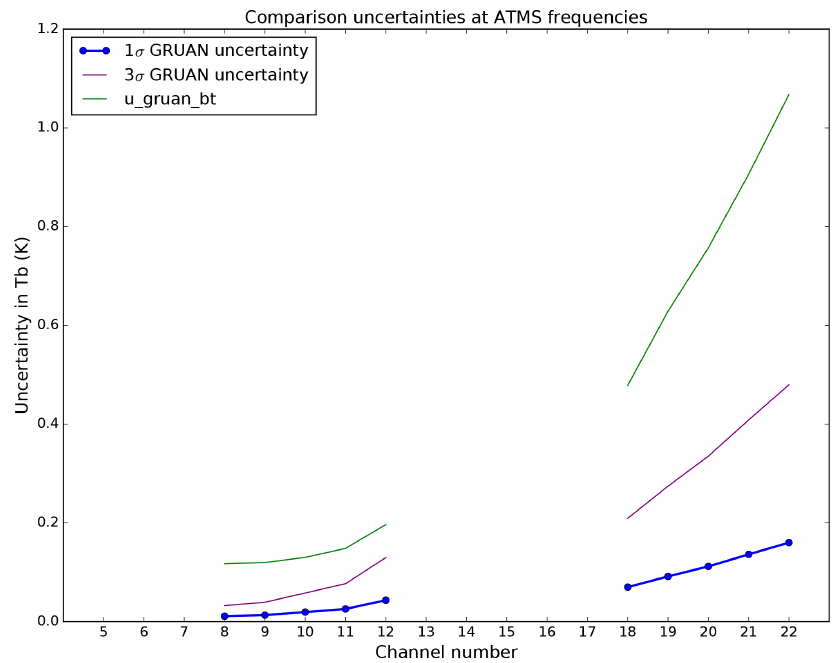
Figure 9. The 1 σ standard deviation of the uncertainty distribution from the GRUAN contribution to S δy is shown in blue (dotted line). It is calculated as the square root of the first three terms of Eq. (26), i.e. p diag ( S q_rs + S T_rs + S P_rs ) . The 3 σ standard deviation of the uncertainty distribution is shown in purple (solid line). u_gruan_bt, the GRUAN uncertainty propagated into radiance space by the GRUAN processor and averaged over the night-time sample, is shown in green (solid